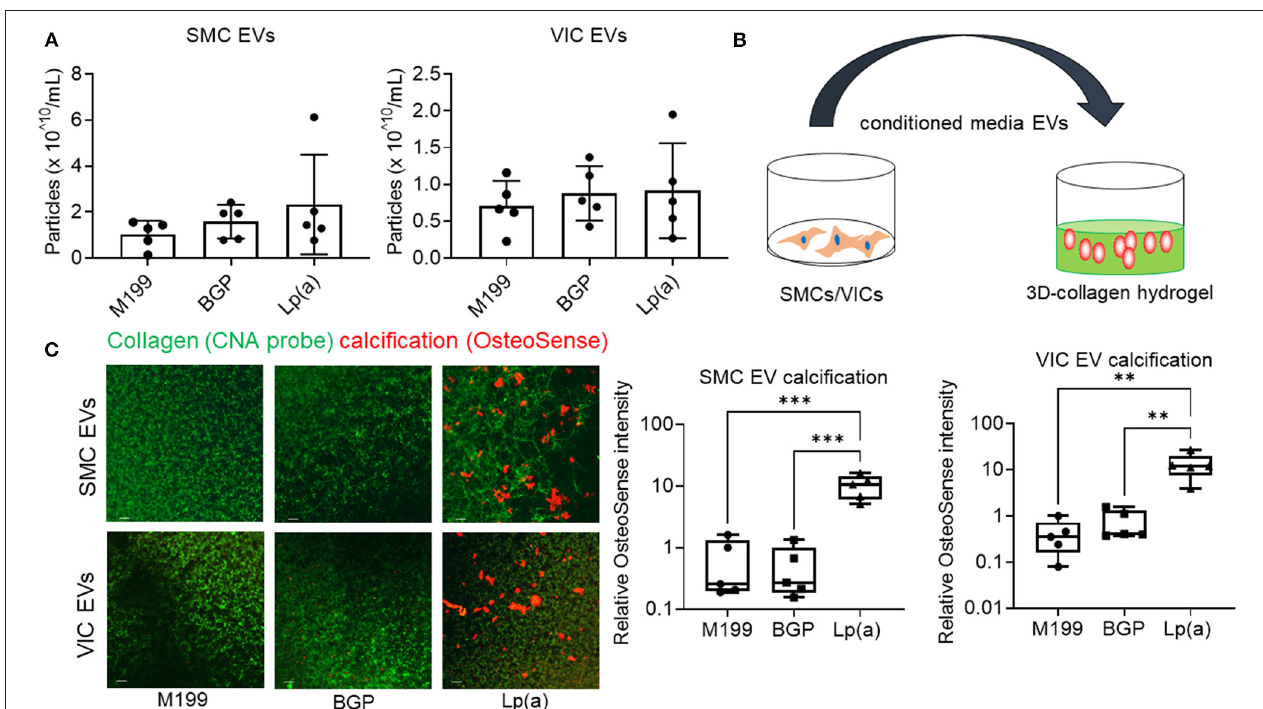
FIGURE 5 | Conditioned media EVs from Lp(a) incubated human cardiovascular cells calcified in 3D-collagen hydrogels. (A) Nanoparticle tracking analysis of EVs concentration for human SMCs and VICs cultured in control M199 media, or calcifying organic phosphate containing media (BGP) without or with Lp(a) (Lp[a]); n = 5 donors, error bars = STDEV. (B) Cartoon of experimental design in which conditioned media containing equal numbers of EVs we transferred to acellular 3D-collagen hydrogels and assessed for calcification potential. (C) Confocal immunofluorescence of conditioned media EVs incubated in 3D-collagen hydrogels and stained for calcification with OsteoSense680 ( n = 5 donors, example images and quantification shown). Analyzed by ANOVA, ** P < 0.01, *** < 0.001; graphed as box and whisker plots showing all data